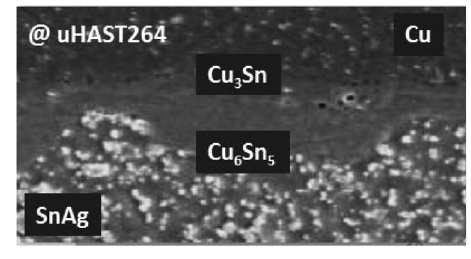
Figure 11. Zoom in section